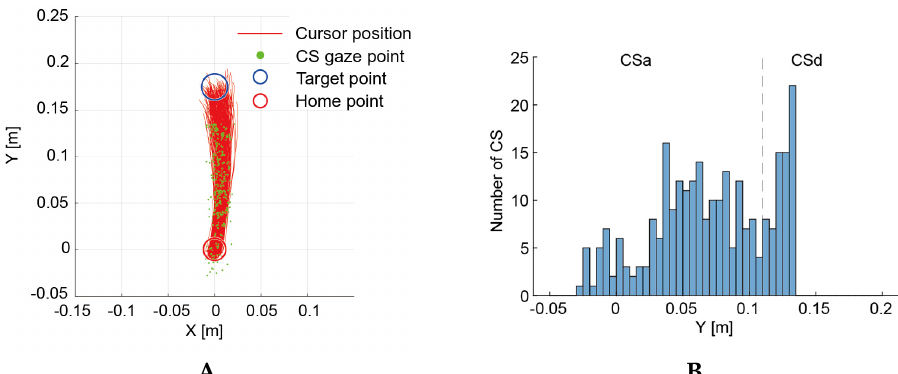
Figure 3. Cursor trajectories of trials with CS and distribution of gaze points directed by CS. ( A ) Cursor trajectories of the hitting trials with CS and gaze points directed by CS in Monkey H . ( B ) Distribution of gaze points directed by CS in y-coordinate. Broken line indicates the border point (0.11 m) of CS in hand acceleration phase (CSa) and CS in hand deceleration phase (CSd).